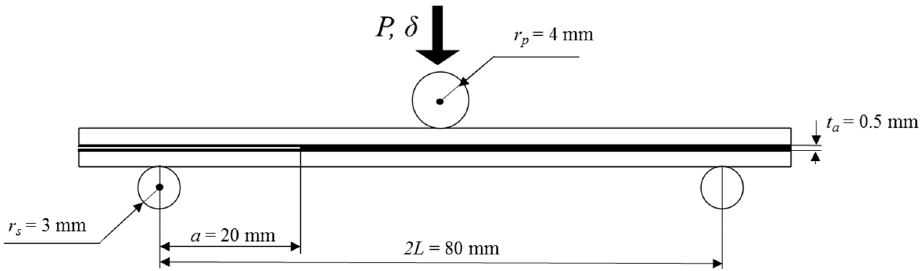
Figure 1. ENF specimen geometry and dimensions adopted in this work.